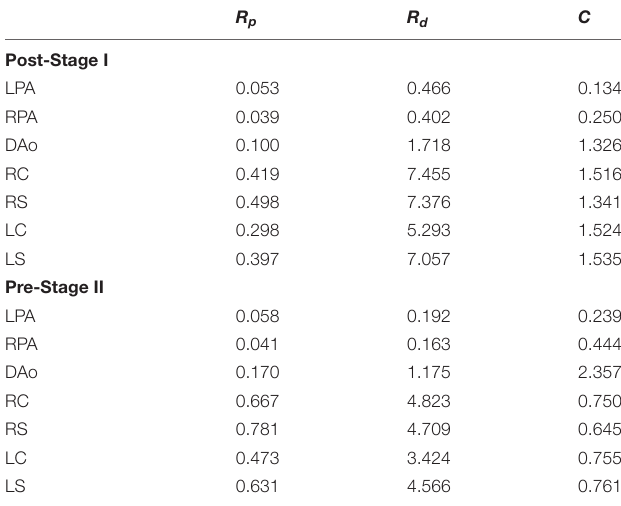
TABLE 4 | Tuned component parameters for the Windkessel models at the outlets of both the post-S1 and pre-S2 models. R p R